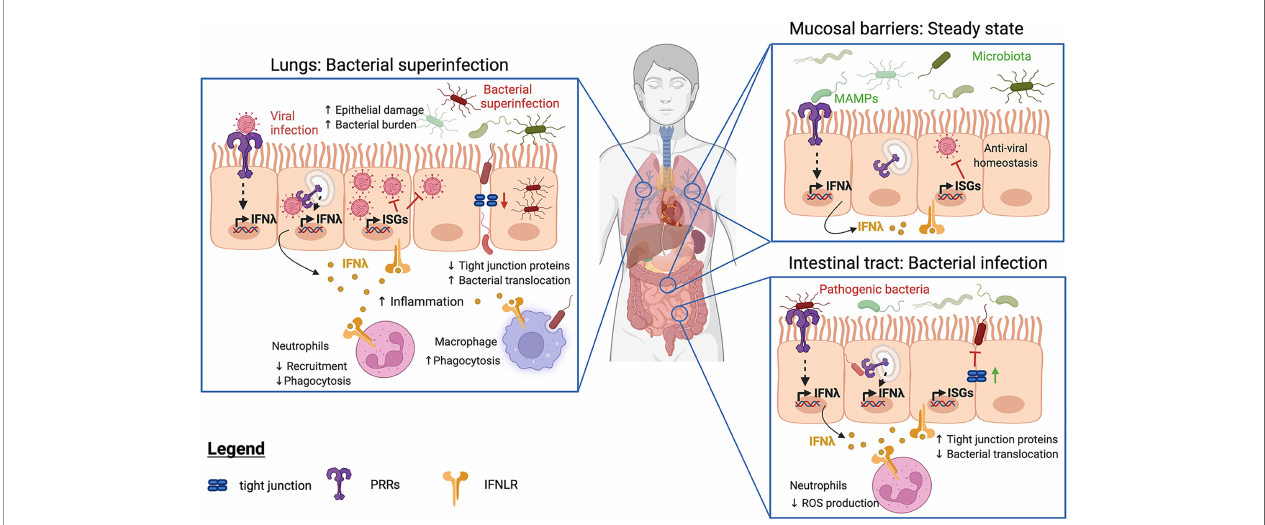
FIGURE 1 | Functions of IFN l at barrier sites at steady state and during bacterial infection. At barrier sites, detection of Microbe-Associated Molecular Patterns (MAMPs) by Pattern Recognition Receptors (PRRs) triggers IFN l production (in yellow) and subsequent expression of IFN-stimulated genes (ISGs). IFN l can enhance (green lines) or inhibit (red lines) host immune responses. In infected or in fl amed lungs (left panel), IFN l and ISGs restrict neutrophil recruitment, resulting in increased bacterial burdens. IFN l also decreases tight junction protein production, facilitating bacterial translocation and promoting bacterial superinfections. In contrast, IFN l promotes the phagocytic activity of macrophages. During bacterial infections of the intestinal tract (lower right panel), IFN l strengthens tight junction proteins, preventing bacterial transmigration. IFN l also impairs neutrophil recruitment and reactive oxygen species (ROS) production to limit tissue destruction. At both sites (top right panel), steady-state detection of the bacterial microbiota induces the production of IFN l s, whose signaling drives homeostatic expression of ISGs. The resulting basal ISG response protects against viral